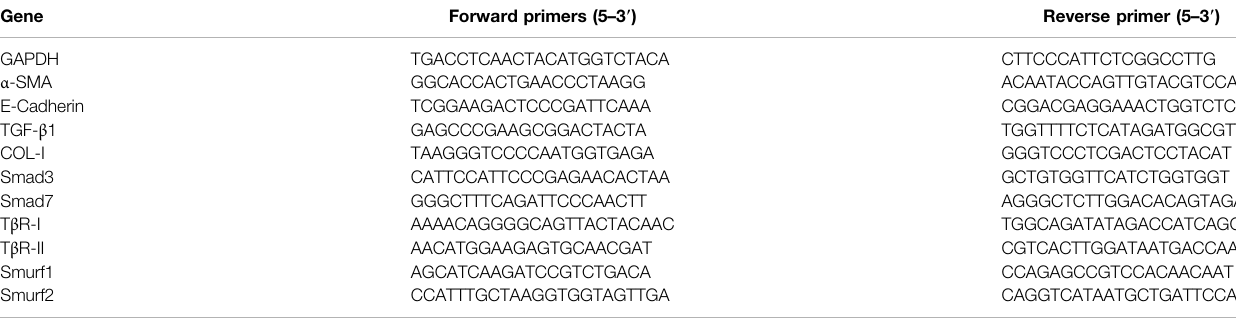
TABLE 1 | Primer sequences for quantitative real-time PCR ampli fi cation (Mouse).